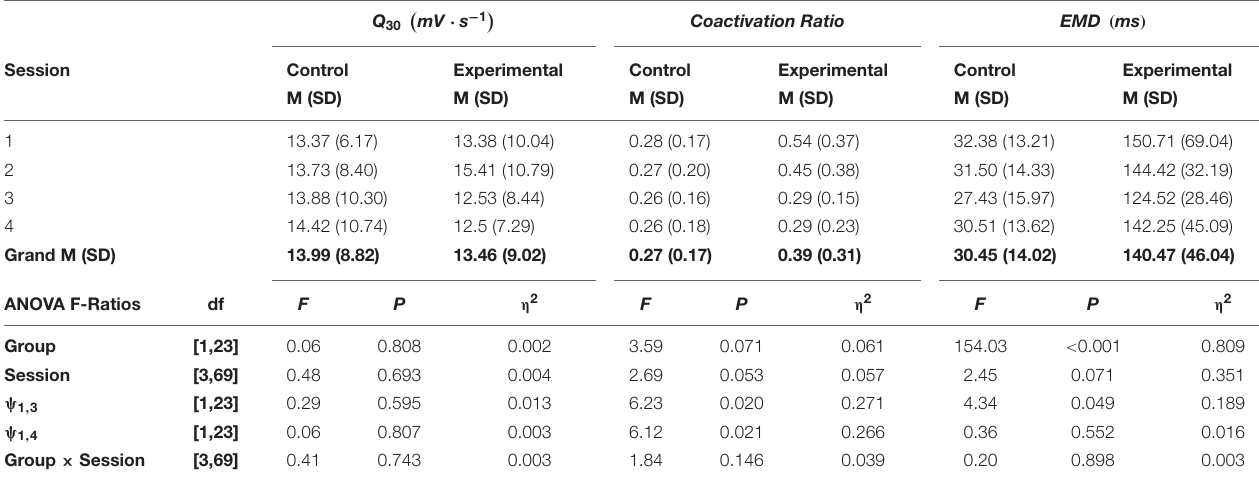
TABLE 3 | The means (M), standard deviations (SD), and F -ratios, degrees of freedom ( df ) and probabilities ( P ) and η 2 effect sizes for maximum rate of increase in flexor carpi radialis muscle activation ( Q 30 ) , the coactivation ratio, and electromechanical delay (EMD) calculated from ANOVAs with planned comparisons ( ψ